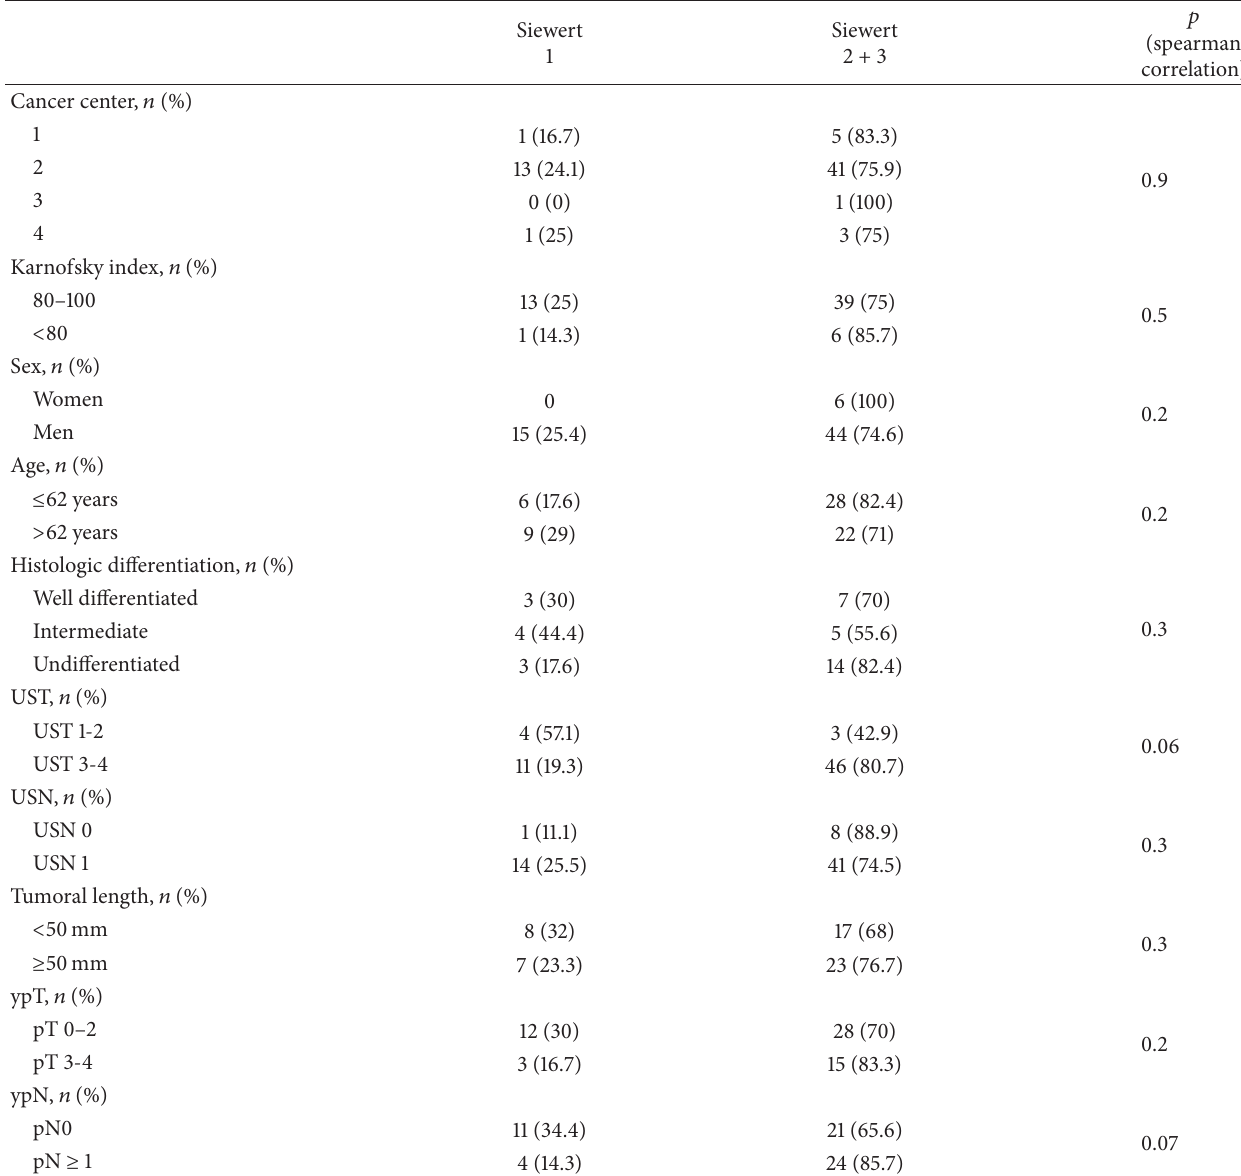
Table 2: Correlation between patients characteristics and Siewert